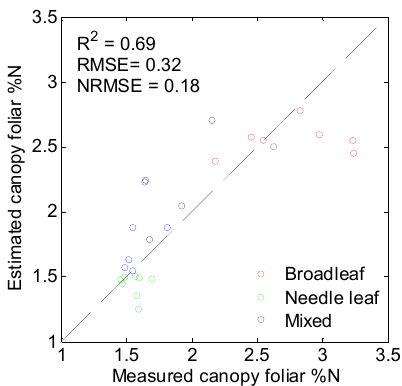
Figure 4. The 1:1 relationship between the estimated and measured canopy foliar %N based on the partial least squares regression (PLSR) model. R 2 , RMSE and NRMSE are values from leave-one-out cross validation.